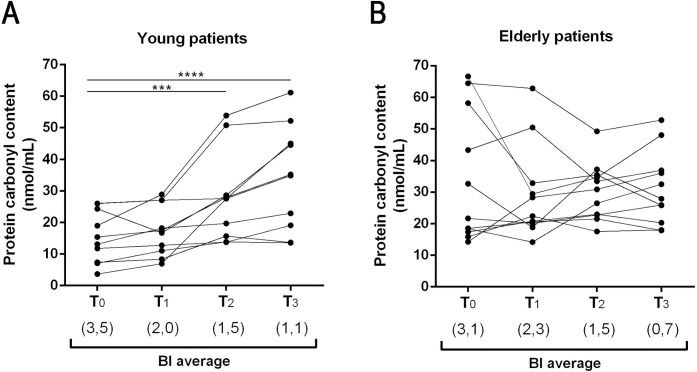
Increase in serum protein carbonyl concentration one year after multidrug therapy (MDT) discharge in the young L-Lep group.(A) Effects of treatment on oxidative stress in Y L-Lep patients (n = 9) and (B) in E L-Lep patients (n = 10): T0 –at diagnosis, before starting MDT; T1—discharge after treatment; T2—one year after discharge; T3—two years after discharge. Each circle represents a patient and lines represent the follow up. The Friedman test was performed to evaluate significant differences between the beginning of MDT and the years following discharge. Values in parenthesis refer to the BI average for each time point. ***P < 0.001 and ****P = 0.0001.